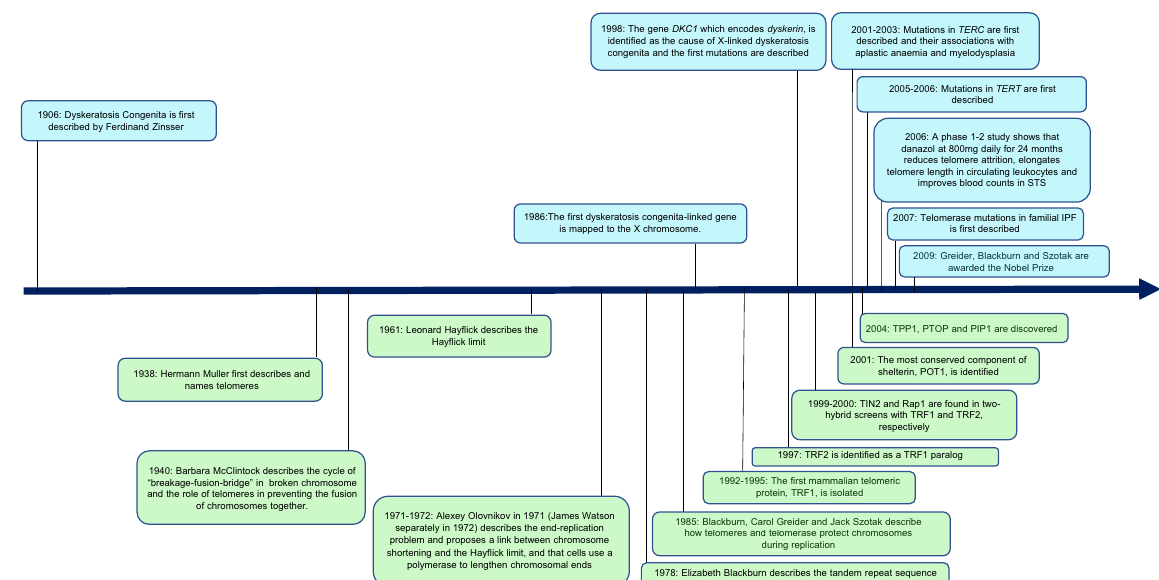
Fig. 1 Timeline of signi fi cant discoveries and developments in telomere biology and their clinical relevance. Since dyskeratosis congenita was fi rst described in the early 1900s, there have been signi fi cant developments in the knowledge of telomere biology over the last century. It is now known that telomeres are DNA-protein structures found at the ends of chromosomes and provide stability to chromosomes and prevent deterioration during cellular replication. Telomere length attrition thus leads to cellular senescence and triggers cell death pathways. Telomere biology disorders are a group of monogenic disorders of premature aging arising due to accelerated shortening of telomere lengths. It has a highly variable presentation due to various germline mutations and incomplete penetrance. Clinical phenotypes vary from multisystem disorders presenting in childhood such as dyskeratosis congenita and single organ disorders such as idiopathic pulmonary fi brosis, which may present in late adulthood. Despite the signi fi cant advancement, the true extent of the syndrome remains unknown and further genetic mutations have yet to be identi fi